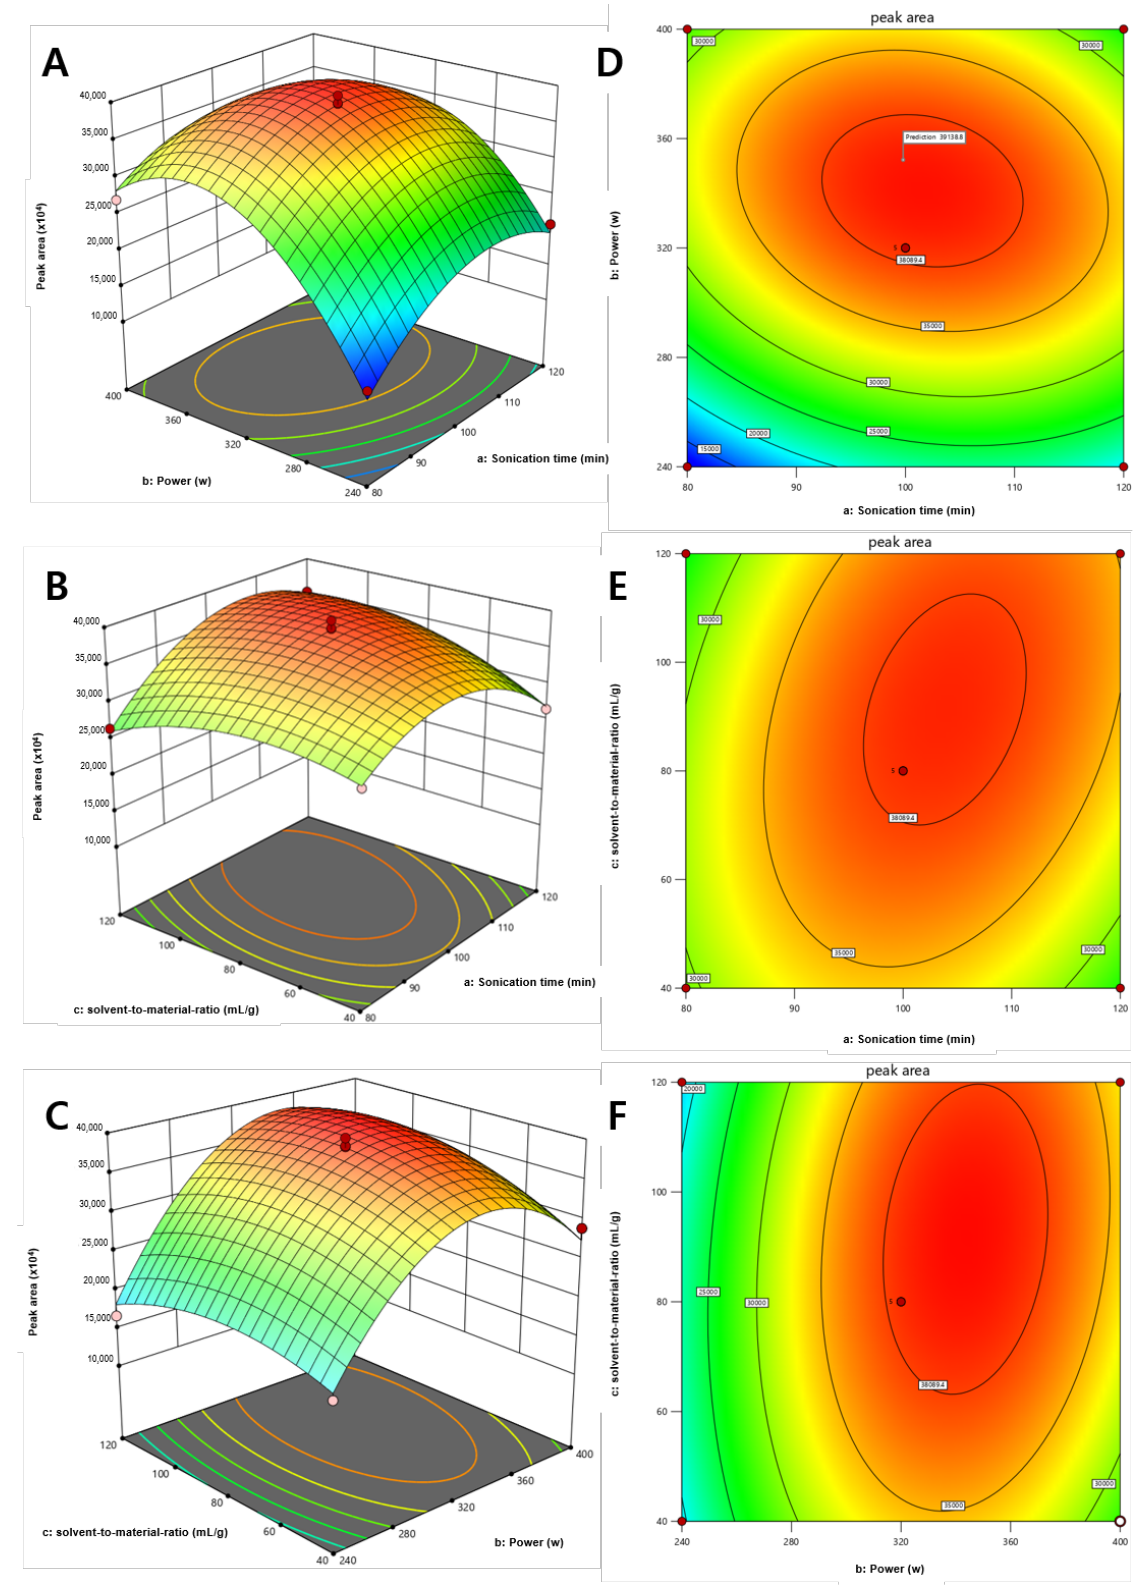
Figure 5. 3D response surface graphs ( A – C ) and contour plots ( D – F ) of D. crassirhizoma under ( A , D ) solvent-to-material ration optimized to 94 mL/g, ( B , E ) sonication power optimized to 342.69 W, and ( C , F ) extraction time optimized to 103.03 min.